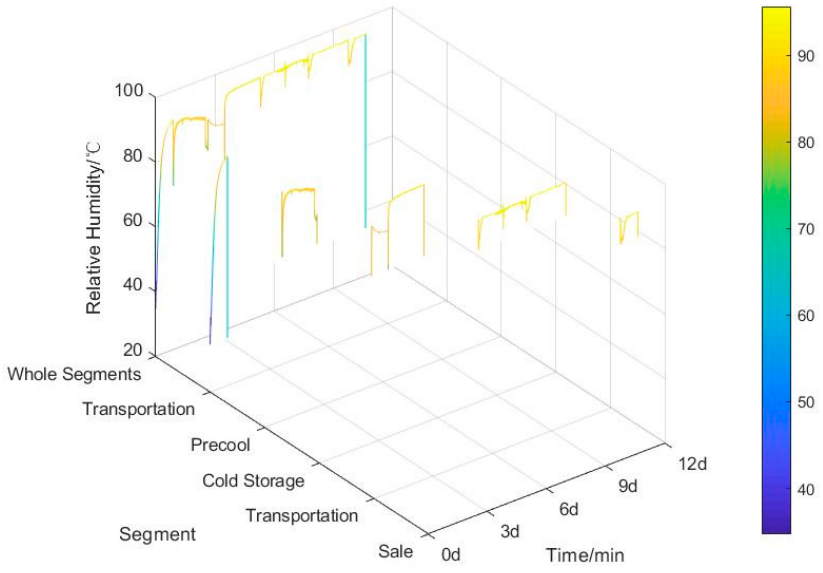
Figure 5. The change of relative humidity in the fragrant pear cold chain. Figure 6. During the ordinary transportation process of fragrant pears, the volume fraction of O 2 declined quickly and the volume fraction of CO 2 inclined quickly in the first segment